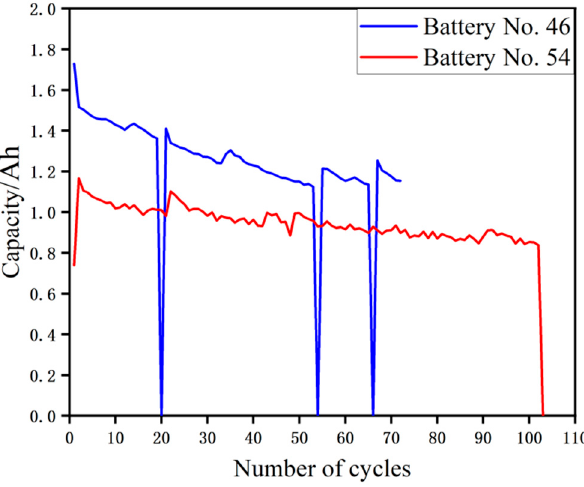
Figure 3. NASA-Battery Data Set No.46 and No.54 battery capacity change.